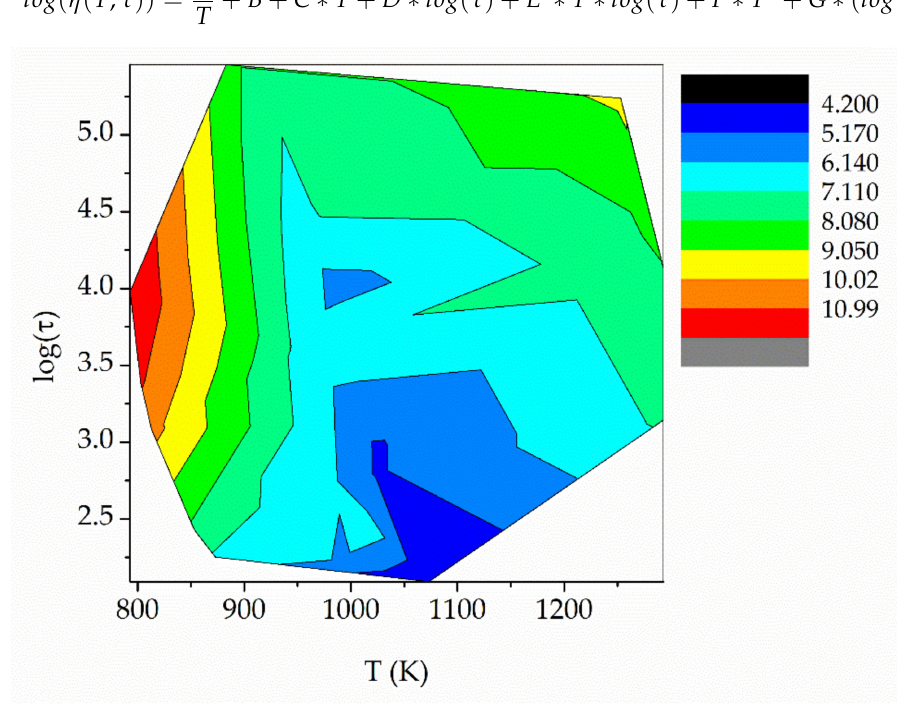
Figure 8. Iso-viscosity lines as a function of T and log( τ ). τ in s, viscosity in Pa